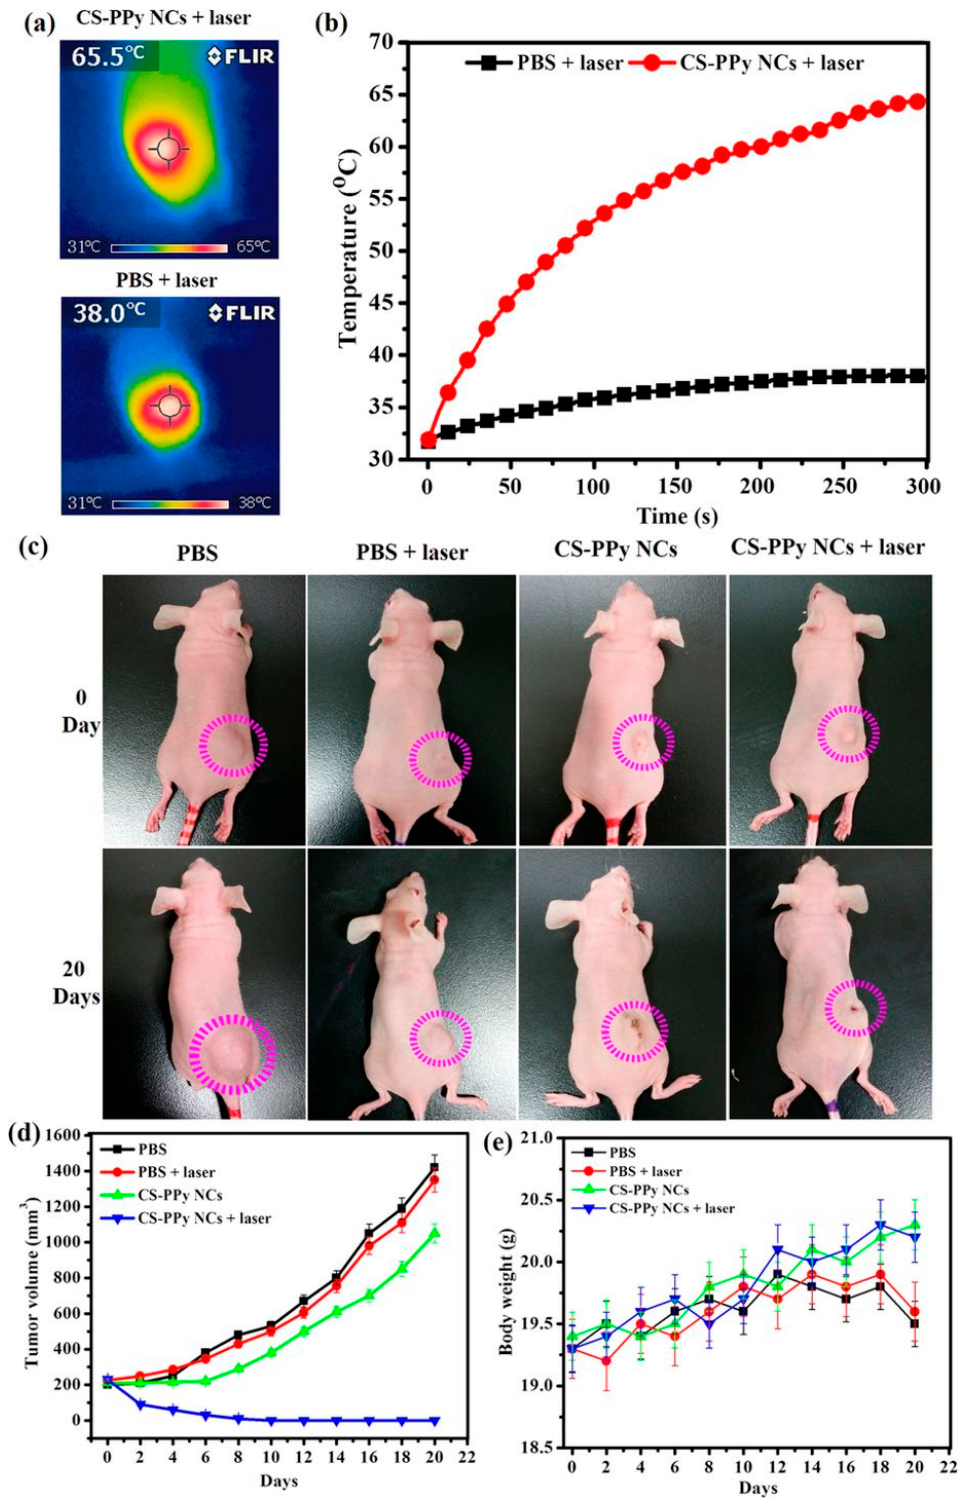
Figure 2. A polypyrrole-based nanocomposite for near-infrared (NIR) photothermal therapy. NIR thermographic images ( a ) and temperature change ( b ) in tumor-bearing mice after intratumoral injection of PBS and chitosan-polypyrrole nanocomposites (CS-PPy NCs) and irradiation with an 808 nm laser (2.0 W cm − 2 , 5 min). ( c ) The change in tumor size between Day 0 (before treatment) and 20 days after treatment. ( d ) Tumor volume growth curves for different groups of mice after different treatments. ( e ) The body weight after different treatments indicated over 20 days. The error bars indicate the mean ± standard deviation. Reproduced from [80] under open access license.